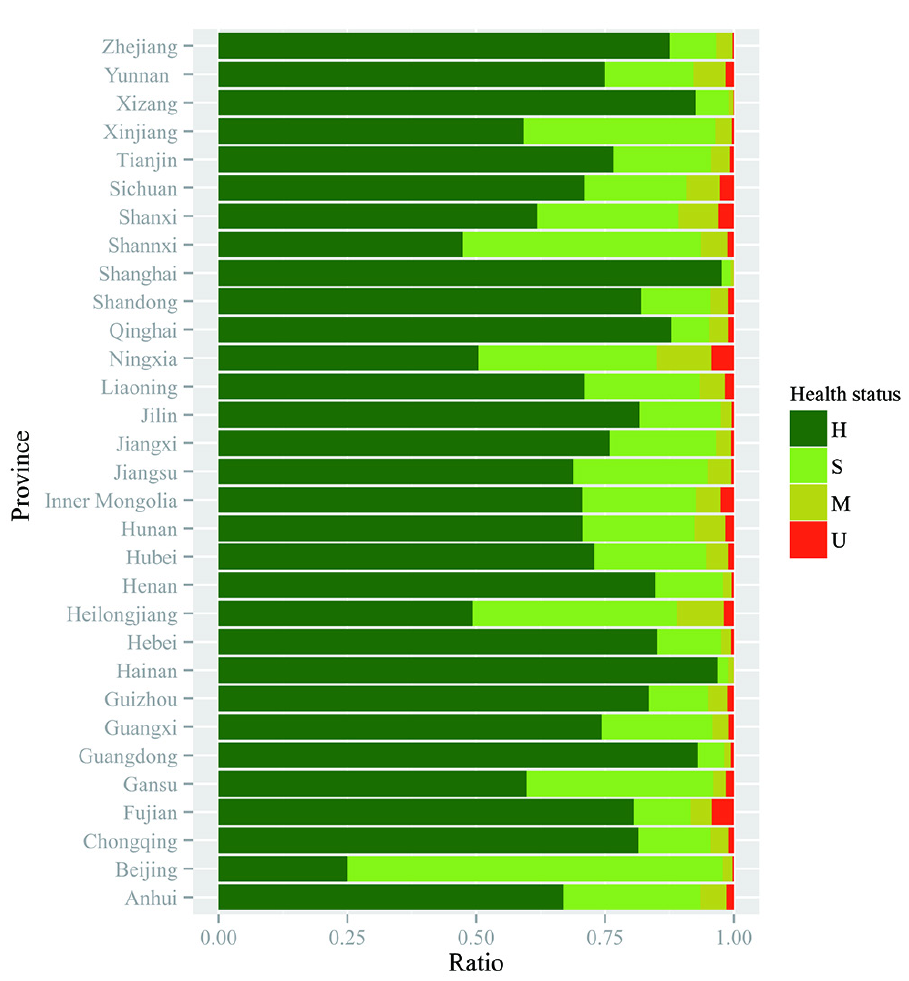
Figure 1. Status of forest health in China as measured in the seventh national forest inventory. “H” represents healthy; “S” represents sub-healthy; “M” represents moderately healthy; “U” represents unhealthy.